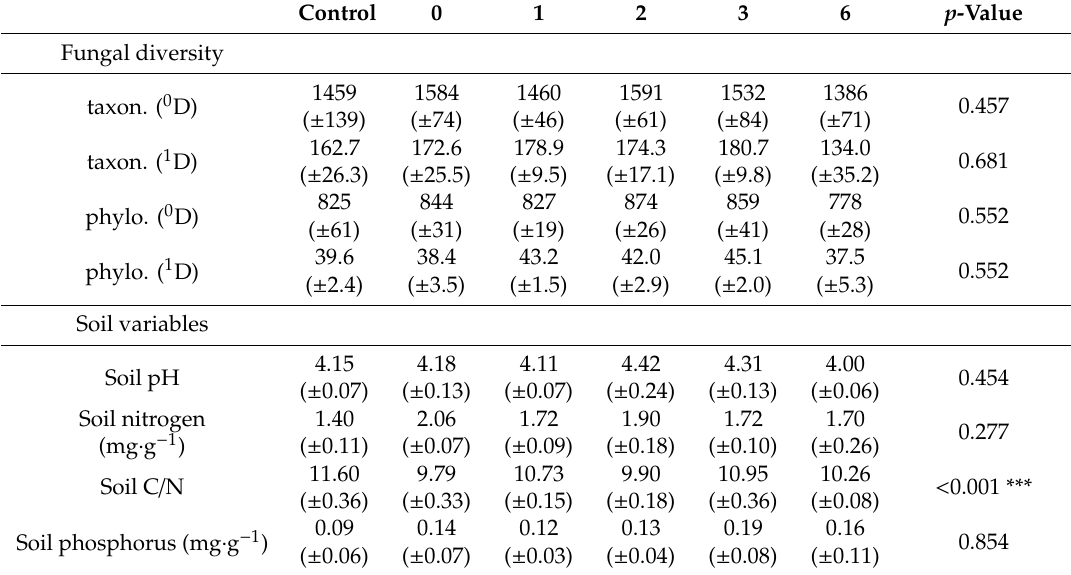
Table 1. Fungal taxonomic (taxon.) and phylogenetic (phylo.) diversity expressed as Hill numbers with weights on operational taxonomic unit (OTU) abundance equal to zero ( 0 D) and one ( 1 D), as well as soil abiotic variables. Means ( ± SD) for conventionally managed oil palm plantations (control) and experimental plots with 0, 1, 2, 3, or 6 di ff erent tree species are shown. The p -values show the results of an ANOVA (nitrogen and phosphorus concentration was transformed by natural logarithm). n = 56, degrees of freedom = 50, *** p <